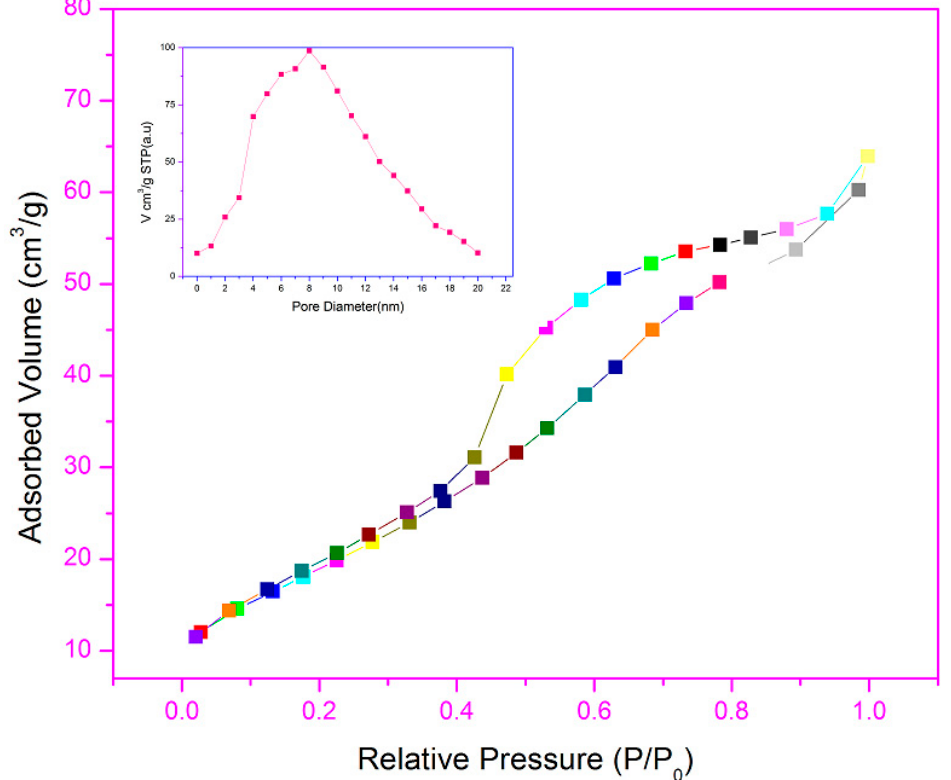
Figure 4. Nitrogen adsorption/desorption isotherm of nickel oxide.